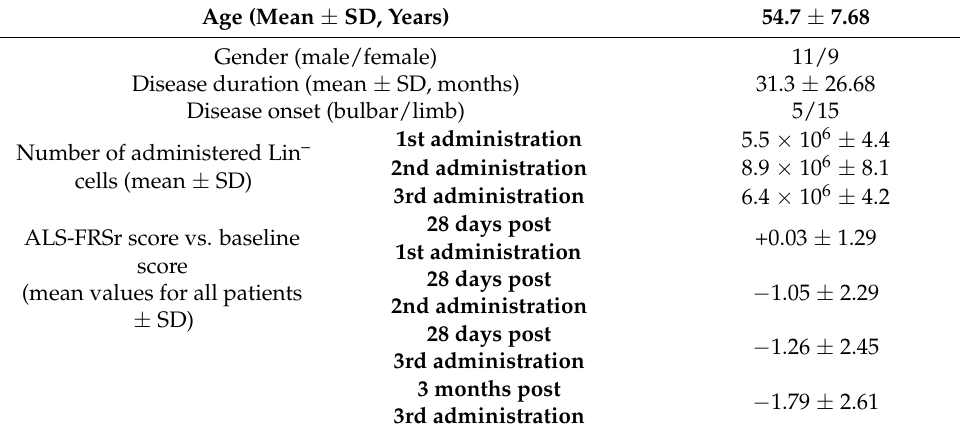
Table 1. Characteristic of study group.